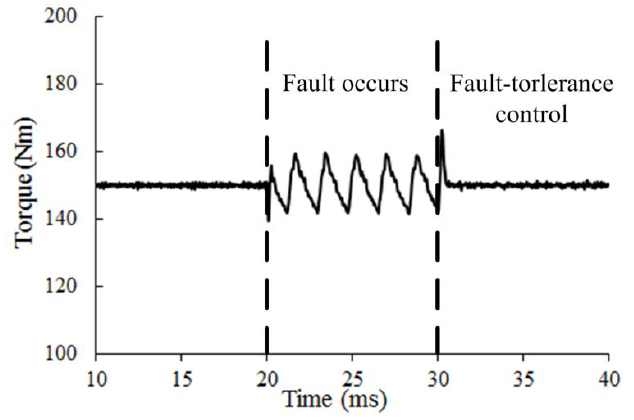
Figure 13. Torque output of the nine-phase FSPM fault-tolerant control.